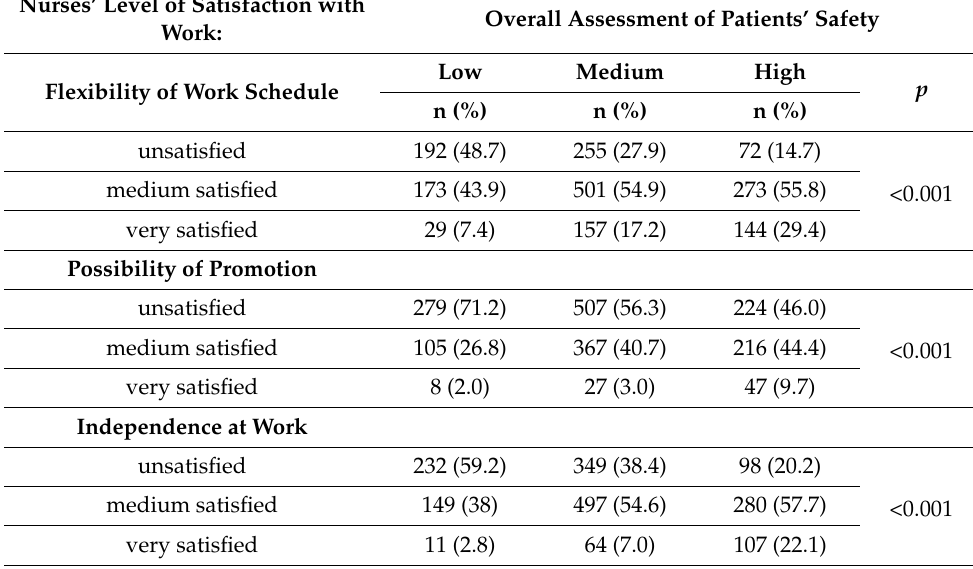
Table 2. Safety and nurses’ satisfaction with various aspects of